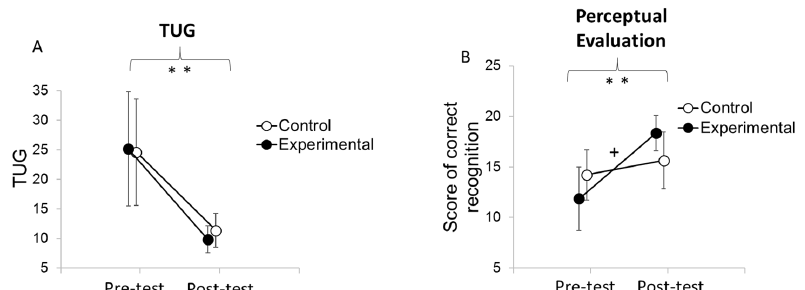
Figure 4. Mean results of TUG and perceptual evaluations by group before and after the rehabilitation program. Error bars represent confidence interval at 95%. ** indicates a difference between pre and post-test at p < 0.001. “+” indicates an interaction between the moment of the evaluation (pre-test, post-test) ( A ) and the group (control, experimental) ( B ) at p < 0.05. Pre-test indicates the level of performance at 0 weeks (before the rehabilitation program), and post-test indicates the level of performance at 3 weeks (at the end of the rehabilitation program).